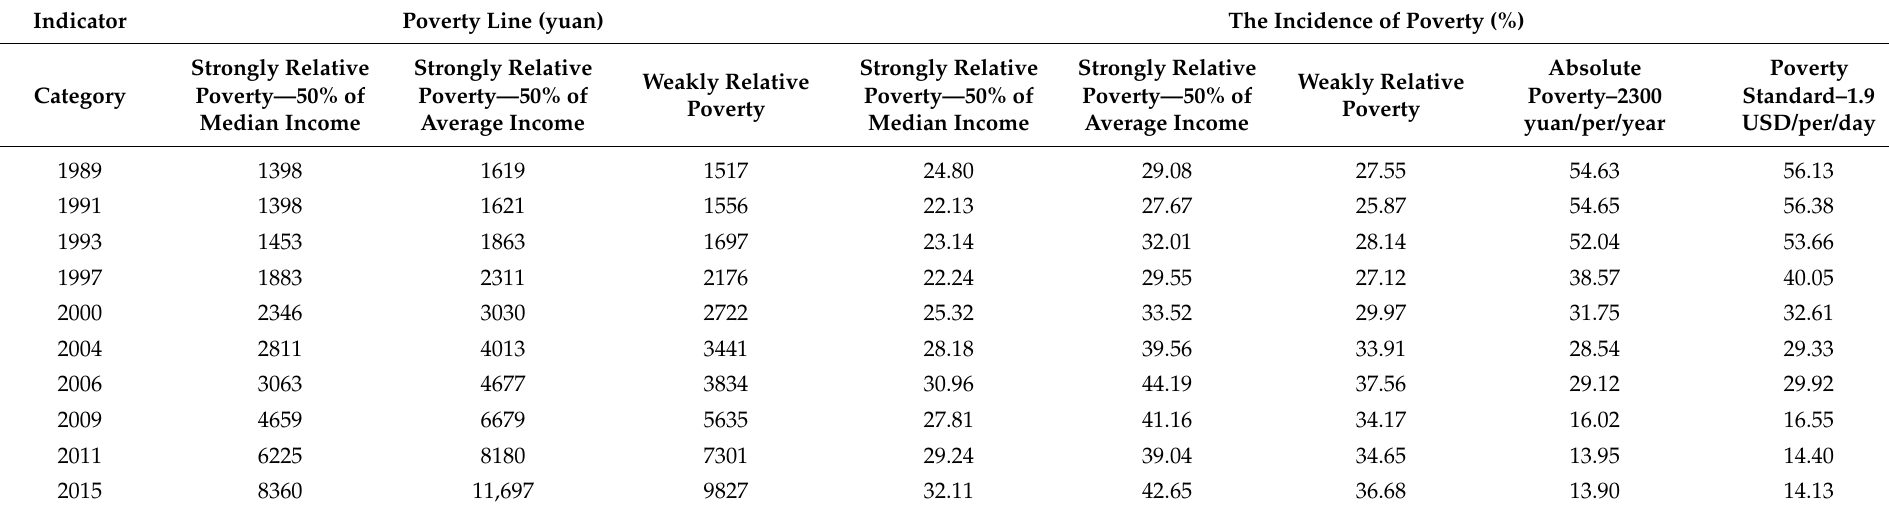
Table 3. Absolute poverty and relative poverty in China from 1989 to